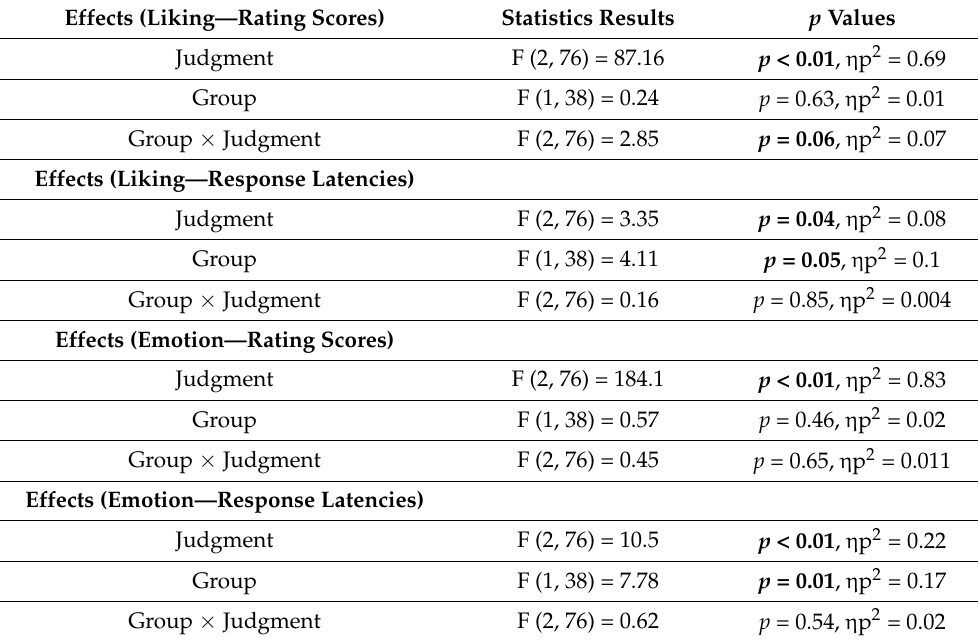
Figure 2. Participants’ mean rating percentage scores for the esthetic evaluation. Error bars represent ± 1 SEM. Asterisks represent significant differences. Table 1. Main statistic results of Experiment #1. Significant p values are reported in